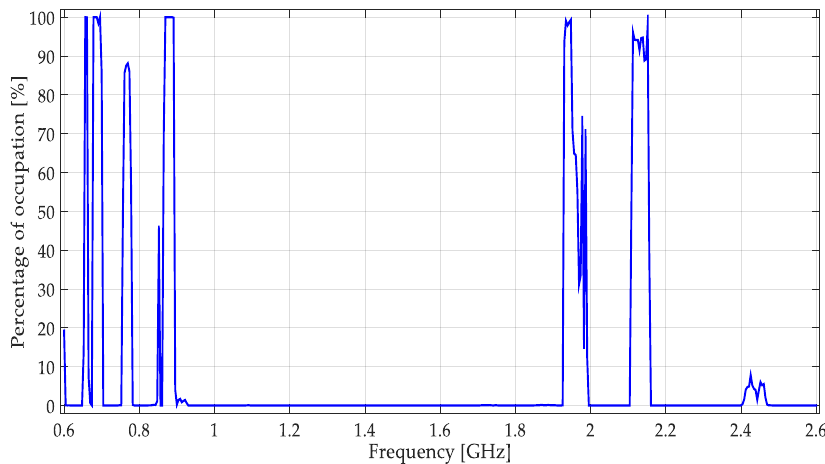
15 of 20 Figure 19. Percentage of success of the second methodology on simulated signals. 4.3. Real Signals To obtain real signals and characterize the multiband spectrum, a small spectrum occupancy measurement campaign was carried out. The data were obtained monitoring the frequency interval